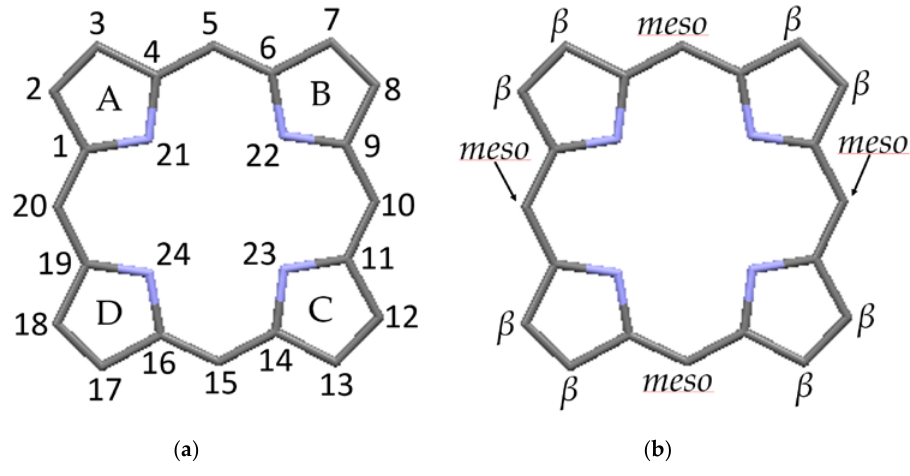
Figure 2. Nomenclature of macrocycle atomic positions [8]: ( a ) numerical designation; and ( b ) site designation.